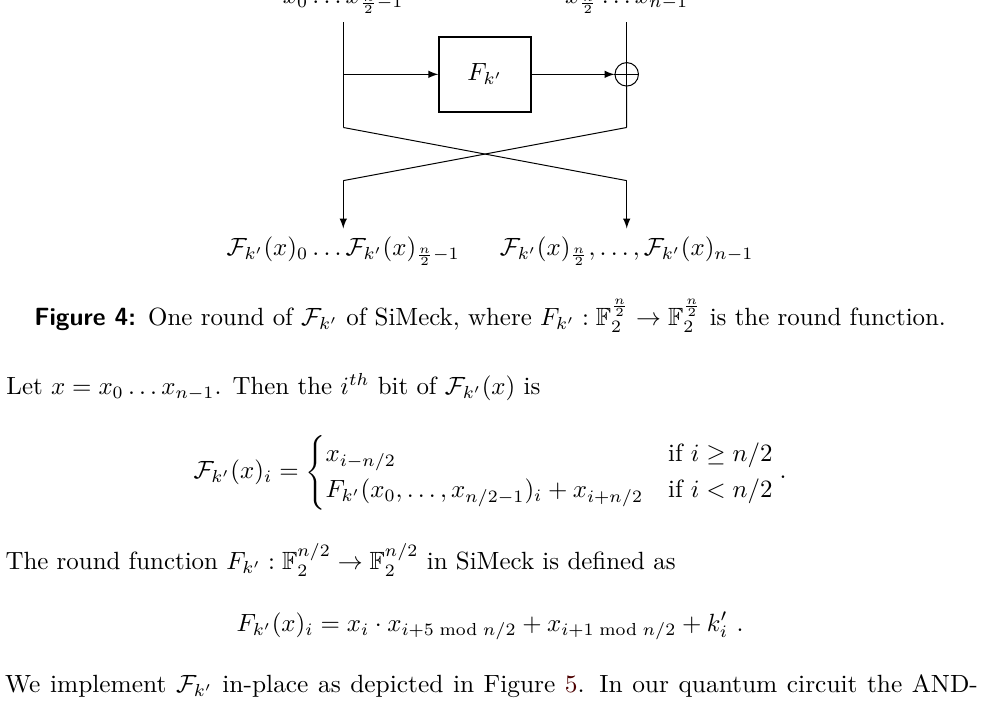
n n → F is the round 2 2 2 2